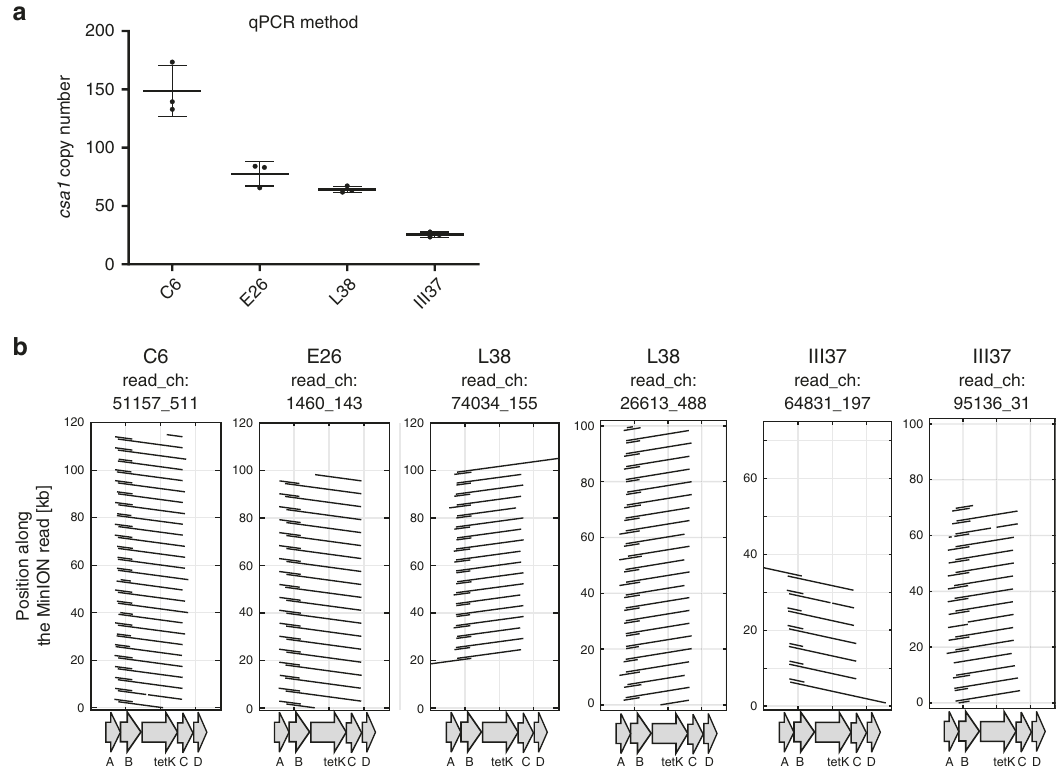
Fig. 3 Tandem ampli fi cation of csa1 :: tetK . a csa1 copy number of four independent, high Tc-resistant strains measured by qPCR. Mean and SD of three replicate qPCRs on a single DNA isolation is shown. Source data are provided as a Source Data fi le. b MinION sequence analysis of high Tc-resistant isolates. For each sequenced isolate, single reads covering the csa1 array were aligned against the csa1::tetK locus of the parental strain. Tandem ampli fi cations manifest as multiple regions within the read with homology to csa1::tetK . Connecting lines within the read are omitted for reasons of clarity. Genes csa1A , csa1B, tetK, csa1C, and csa1D are indicated. Shown are read_ch:51157_511 (C6), read_ch:1460_143 (E28), read_ch:74034_155 (L38), and read_ch: 64813_197 (III37). Source data are provided as a Source Data fi